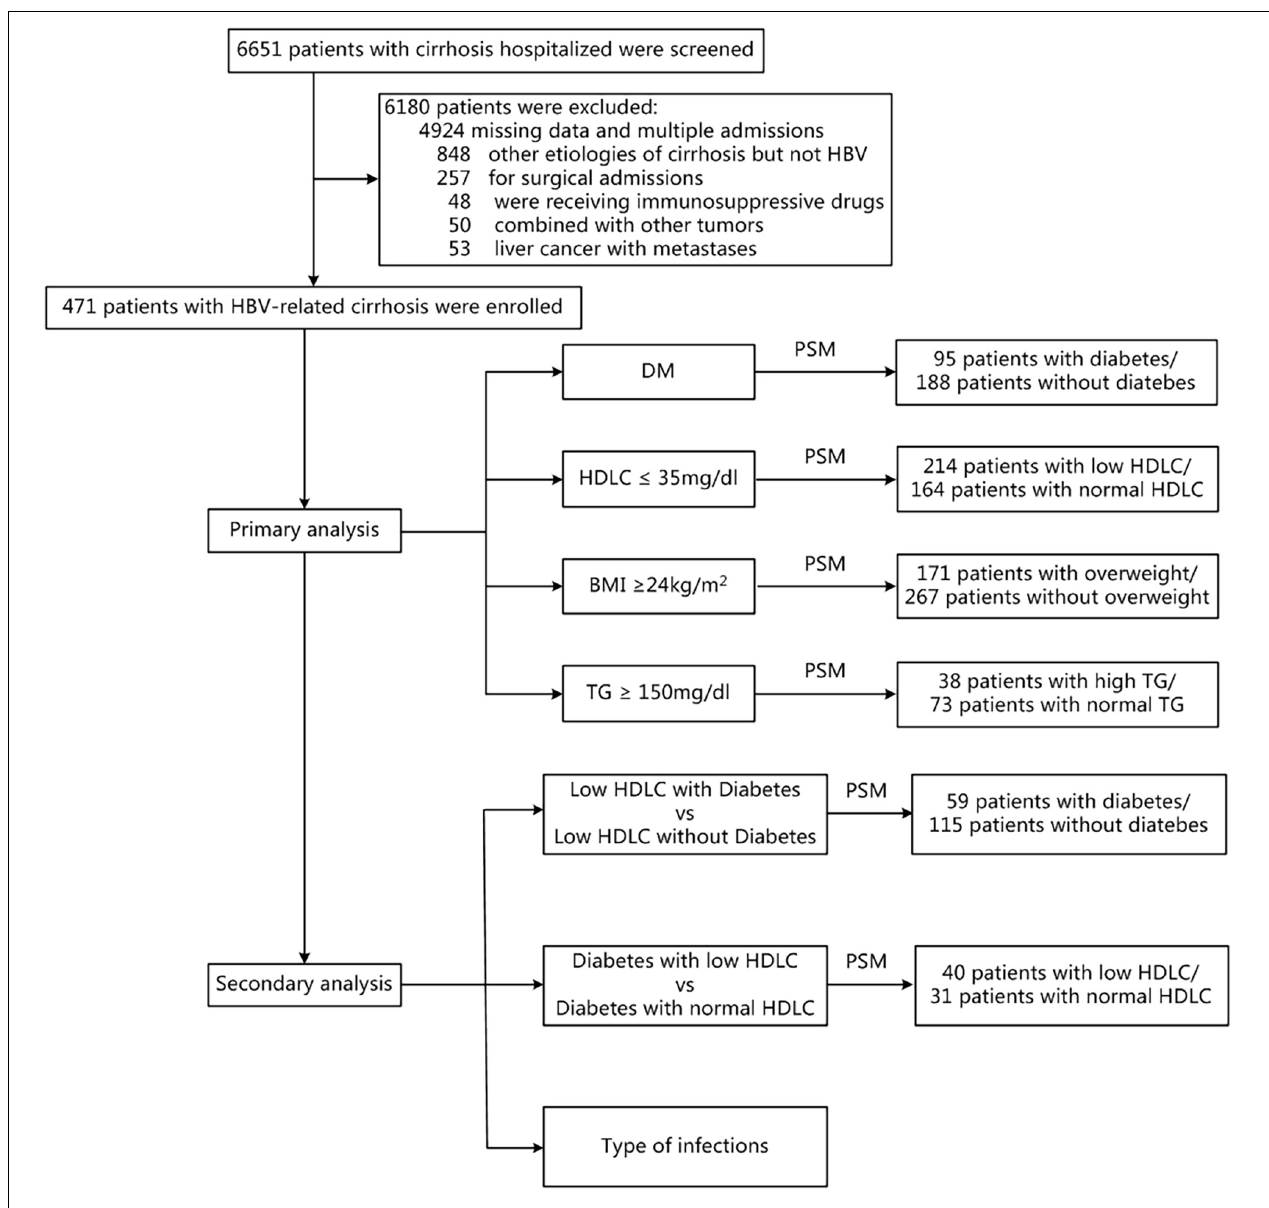
FIGURE 1 | Flow chart of patient selection. BMI, body mass index; DM, diabetes mellitus; HDLC, high-density lipoprotein cholesterol; PSM, propensity score matching; TG, triglyceride.